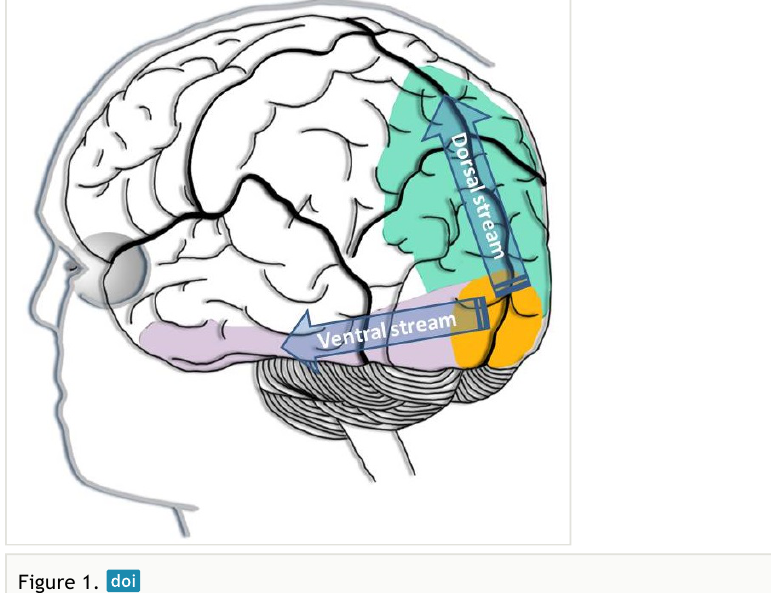
Visual information processing in the cortex. From the primary visual cortex (V1, shown in yellow), the visual information is passed in two streams. The neurons along the ventral stream also known as the ventral visual cortex (shown in purple) are primarily concerned with what the object is. The ventral visual stream runs into the inferior temporal lobe. The neurons along the dorsal stream also known the dorsal visual cortex (shown in green) are primarily concerned with where the object is. The dorsal visual stream runs into the parietal